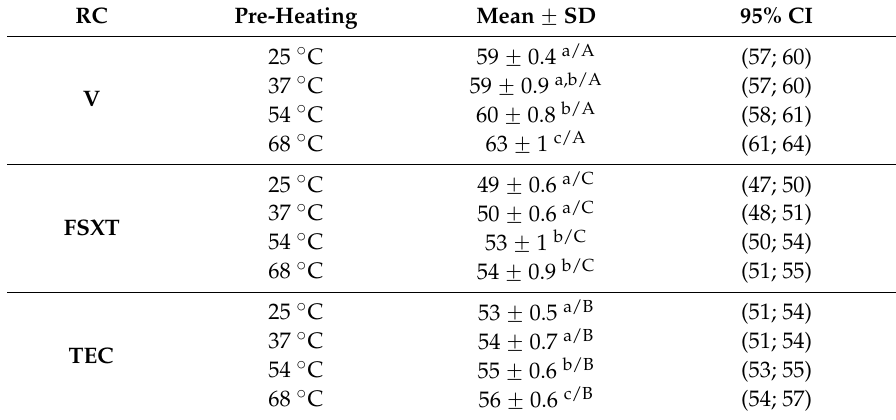
Table 5. Mean with standard deviation for interfacial tension (IFT) (mN/m) as well as 95% confidence interval (CI) for each tested RC by each pre-heating temperature. RC Pre-Heating Mean ˘